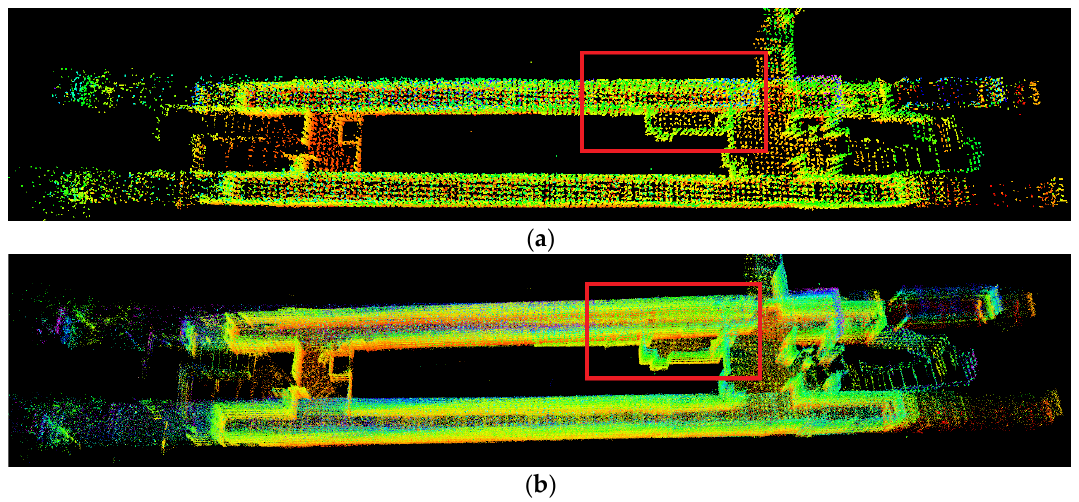
Figure 9. Point cloud map constructed for Scene 2: ( a ) by LeGO-LOAM; and ( b ) by LeGO-LOAM-SM.